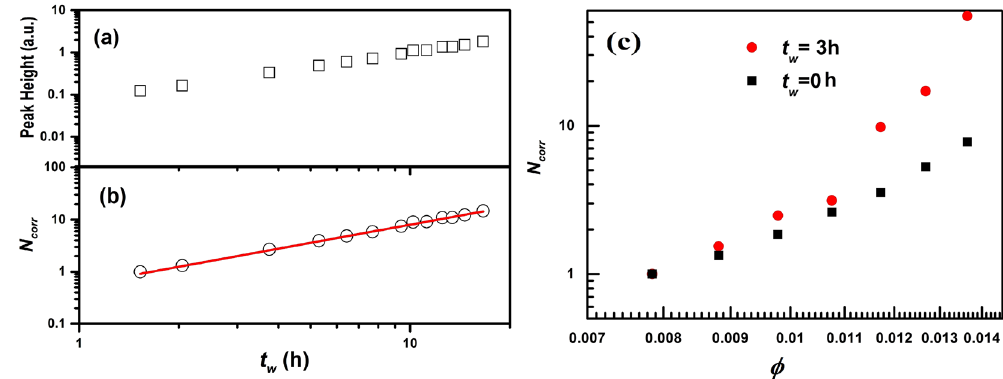
Figure 4. ( a ) Growth of peak height and ( b ) N corr calculated from the data in Fig. 3(b) vs. t w as the sample approaches the non-ergodic state. The solid line in ( b ) is a power law fit of the form N corr = B ( t w ) γ where γ = 1.17 ± 0.02 and B = 0.56 ± 0.04. ( c ) N